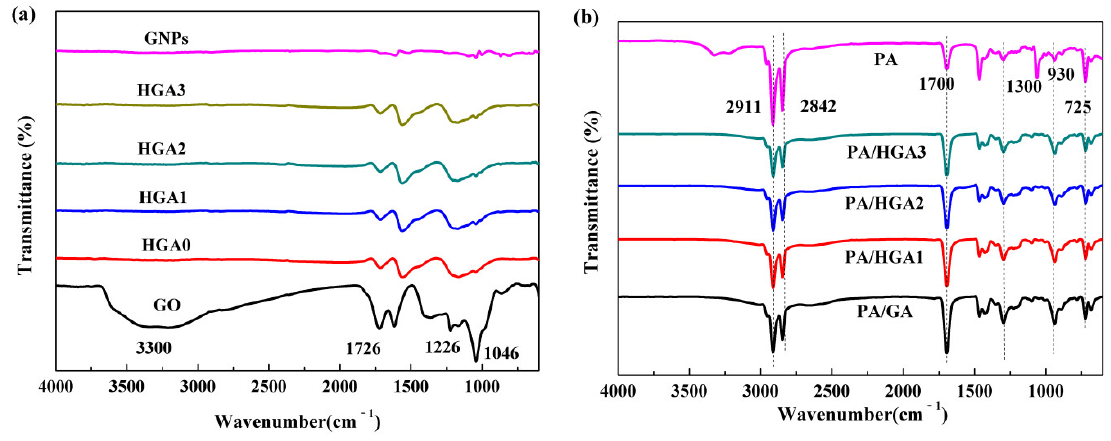
Figure 4. FT-IR spectrum of HGA ( a ) and PA/HGA ( b ).